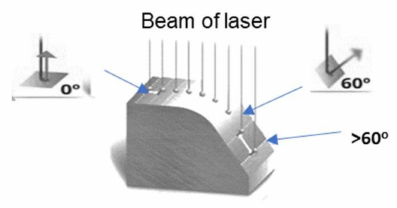
Figure 1. Example of the operation of a scanning angle filter for various angle